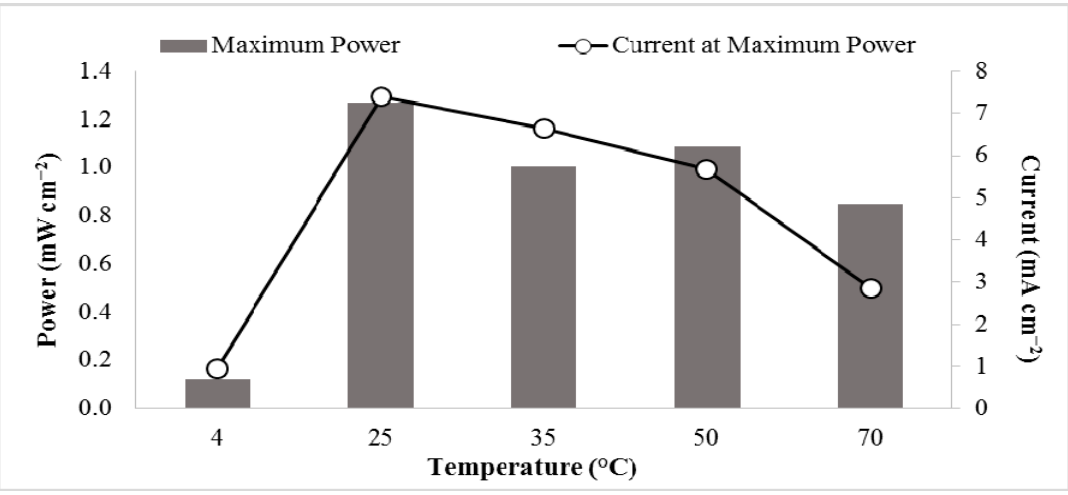
Figure 4. Power output of 1.4 M glycerol and 8 M KOH at various temperatures, 4 °C, 25 °C, 35 °C, 50 °C and 70 °C.